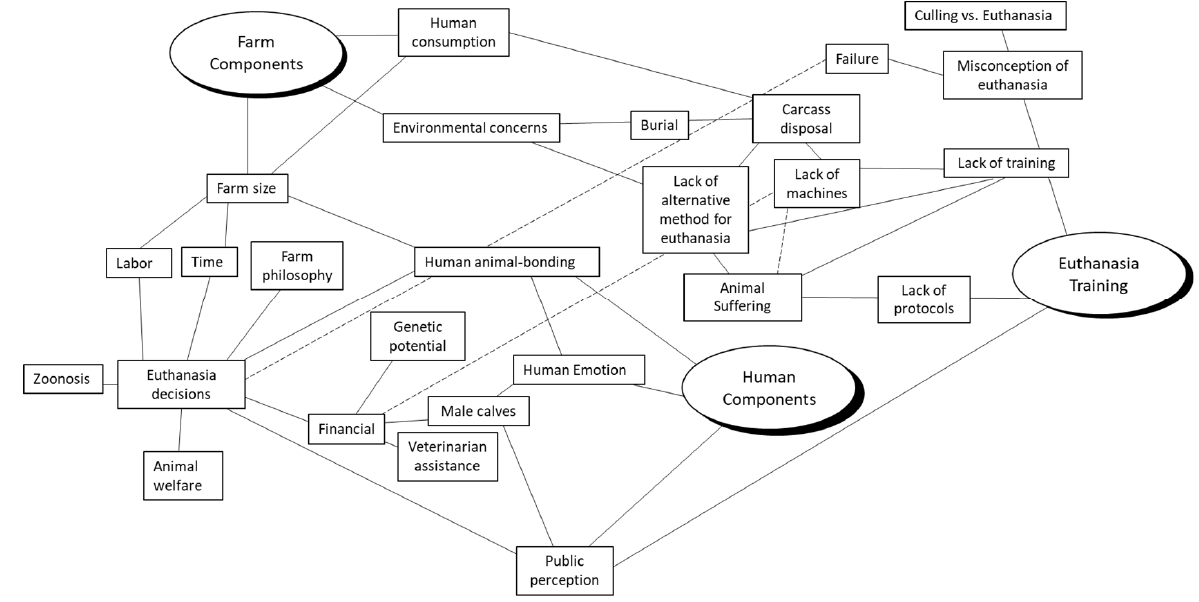
Figure 1. Initial thematic map.